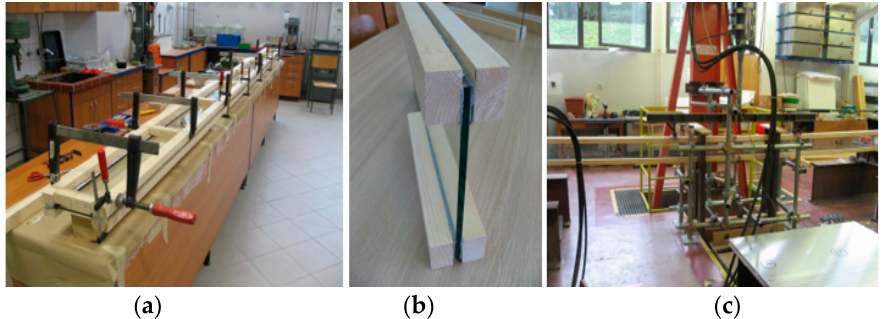
Figure 12. ( a ) glued beam; ( b ) final appearance of TGIB with acrylate adhesive; ( c ) TGIB during four-point bending test.